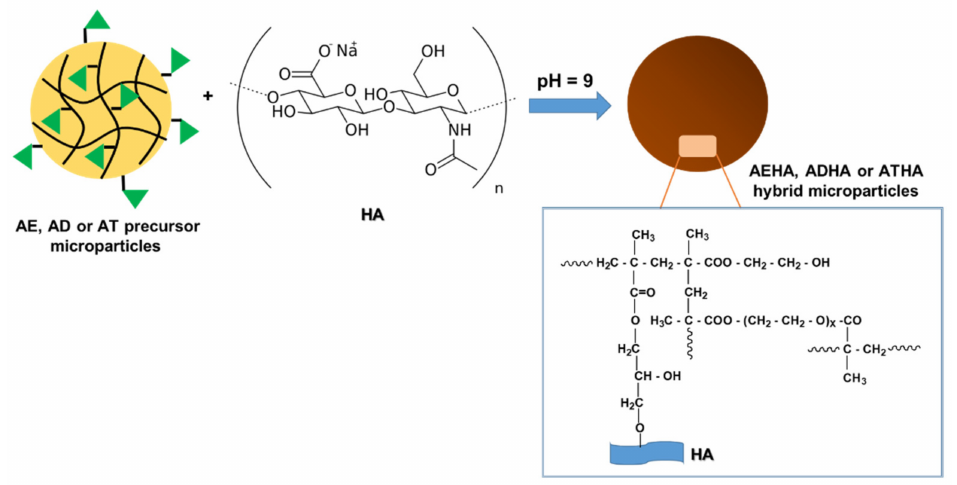
Figure 2. Schematic representation of the reaction to obtain hybrid microparticles (AEHA, ADHA or ATHA).